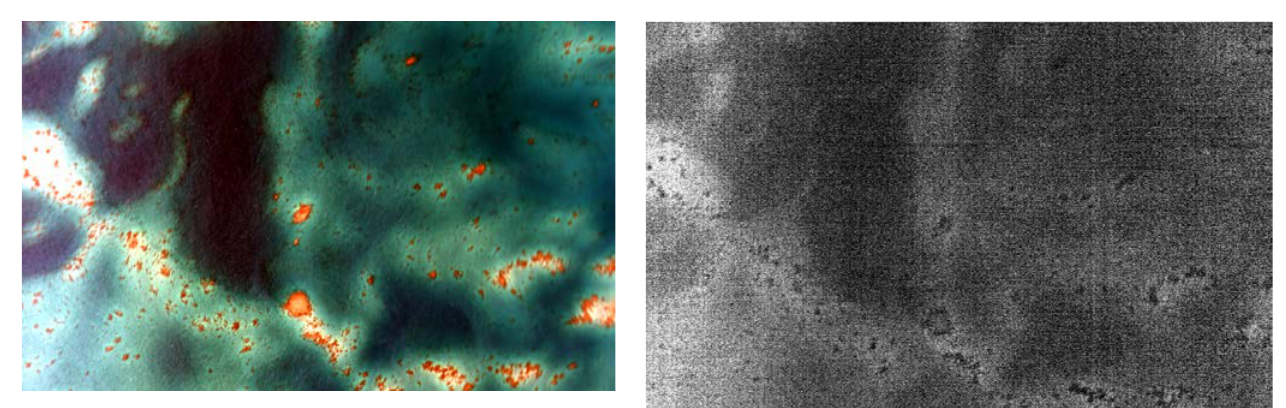
Figure 1. True color combination (central wavelengths 640, 551, and 461 nm) from the SpecTIR Red Sea dataset, © 2012 SpecTIR